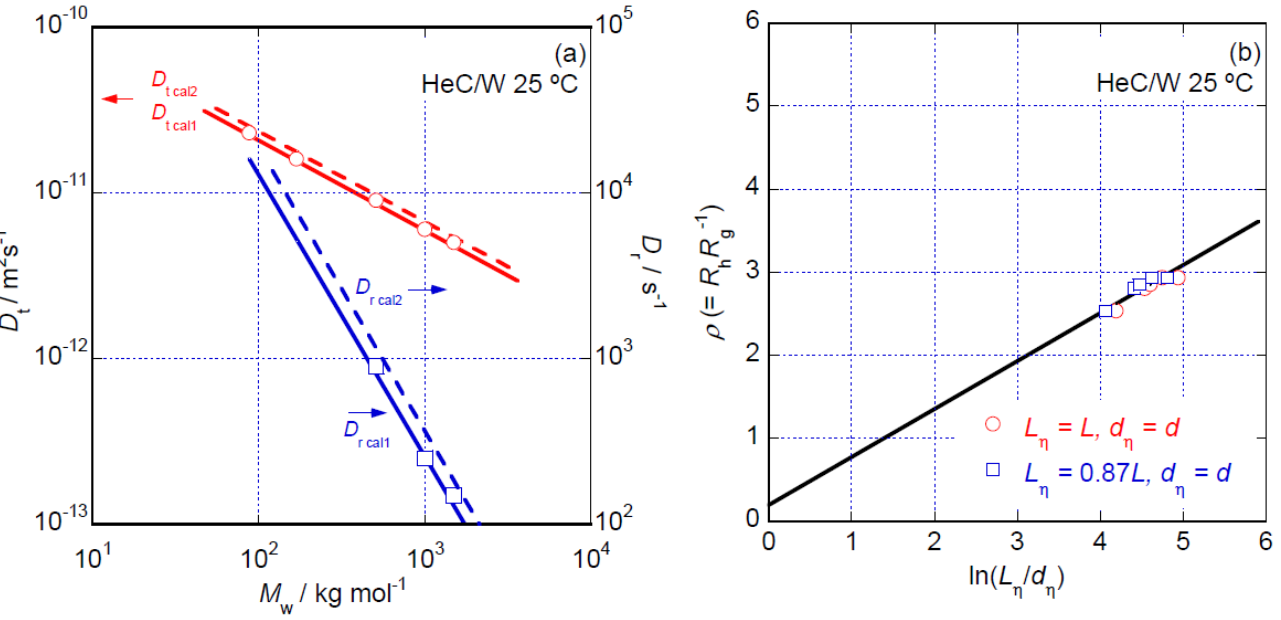
Figure 9. ( a ) M w dependencies of D t and D r data for the HeC samples in aqueous solution at 25 °C. The solid lines show D t cal1 and D r cal1 calculated assuming L h = L and d h = d , and the broken lines show D t cal2 and D r cal2 calculated assuming L h = 0.87 L and d h = d, as in the M w dependencies of the [ η ] data seen in Figure 7. ( b ) Dependence of ρ (= R h R g −1 ) on ln( L h d h −1 ) for all the HeC samples in aqueous solution at 25 °C assuming the first condition, L h = L and d h = d (circular symbols), and the second condition, L h = 0.87 L and d h = d (square symbols).